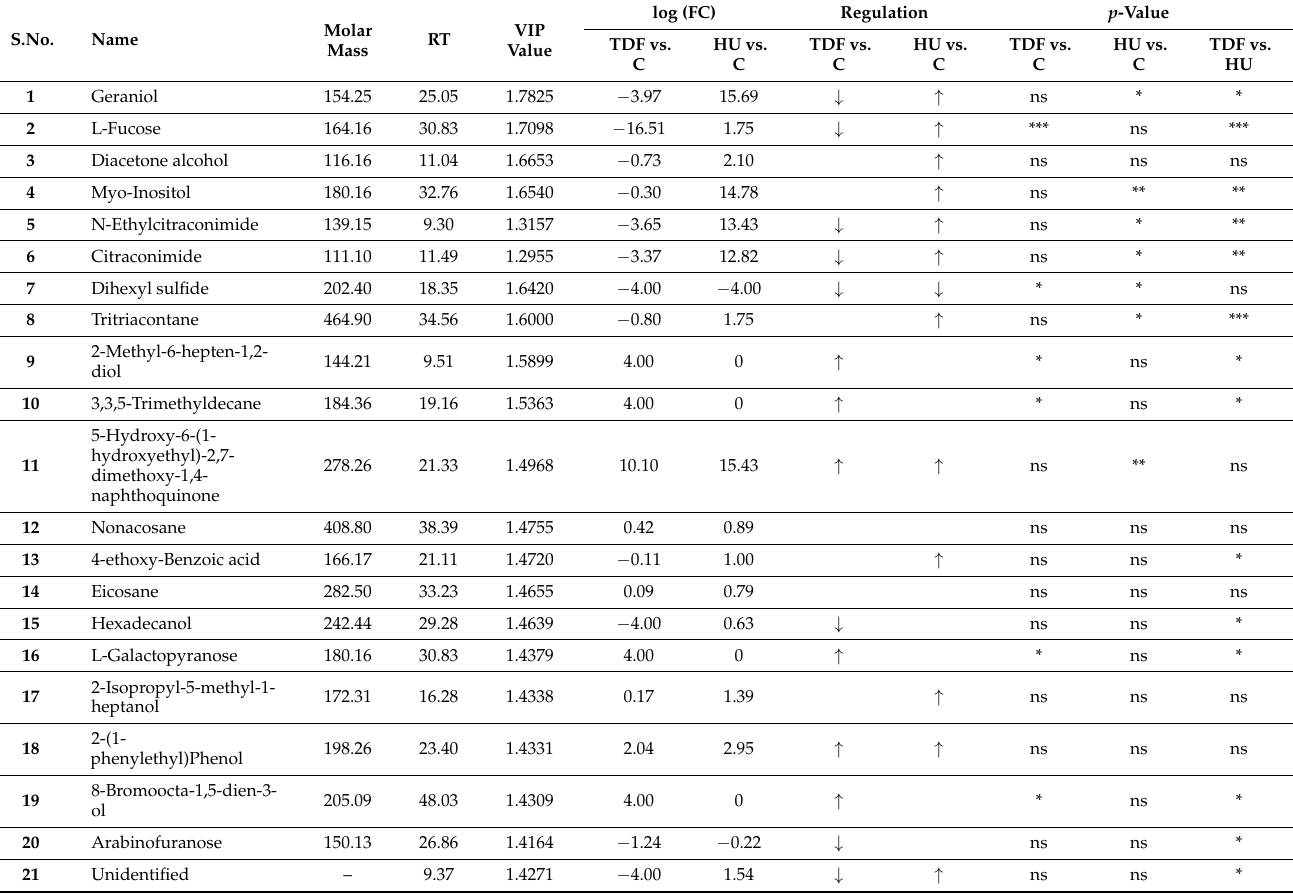
Figure 1. Significant metabolites showing up-regulation and down-regulation at log FC > 1.0 in two groups: blue indicates HU vs. C and red indicates TDF vs. C. Table 1. List of identified metabolites significantly different in groups: Group 1, TDF vs. C; Group 2, HU vs. C showing up/down-regulation with log FC > 1 and VIP > 1.3.